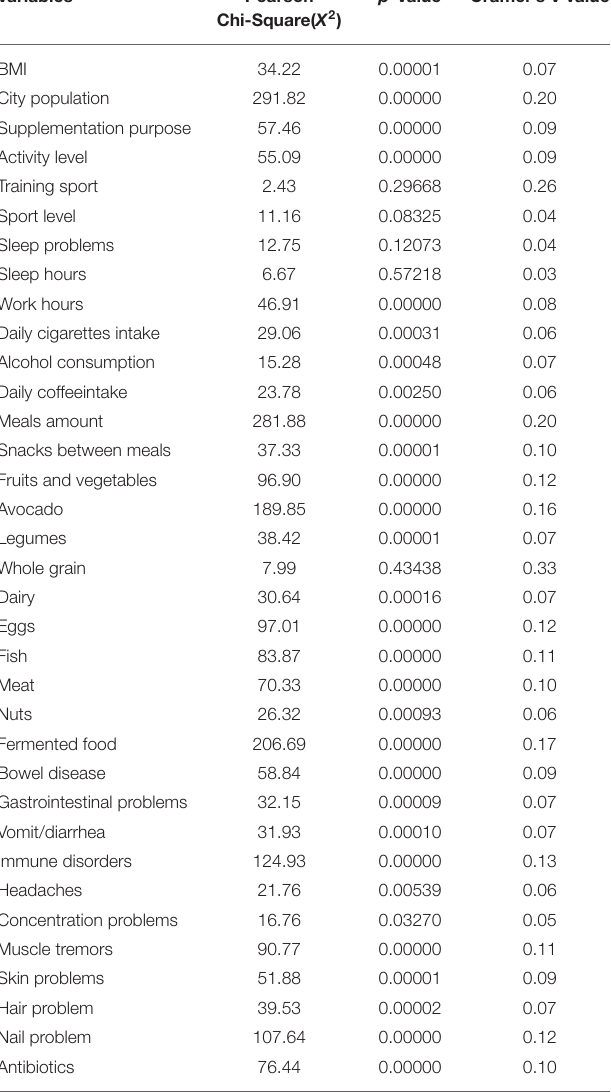
TABLE 6 | Generalized linear regression model (GRM) for an average cost of a purchased DS.